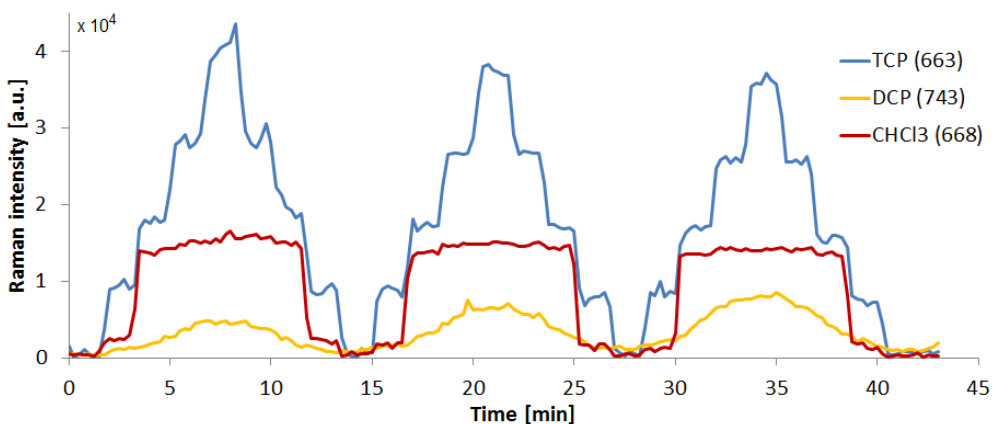
Figure 13. Time course of the SK307 SERS signal from TCP, DCP, and CHCl 3 solutions during 3× repeated step gradient from 0 to 10 mM and back to 0 with 2.5 mM steps. Raman shift of the projected signal (in cm −1 ) is given in brackets along with the sample name. Note the various dynamics of the signal change. The pumping programs and spectral acquisition parameters were identical in all three samples.